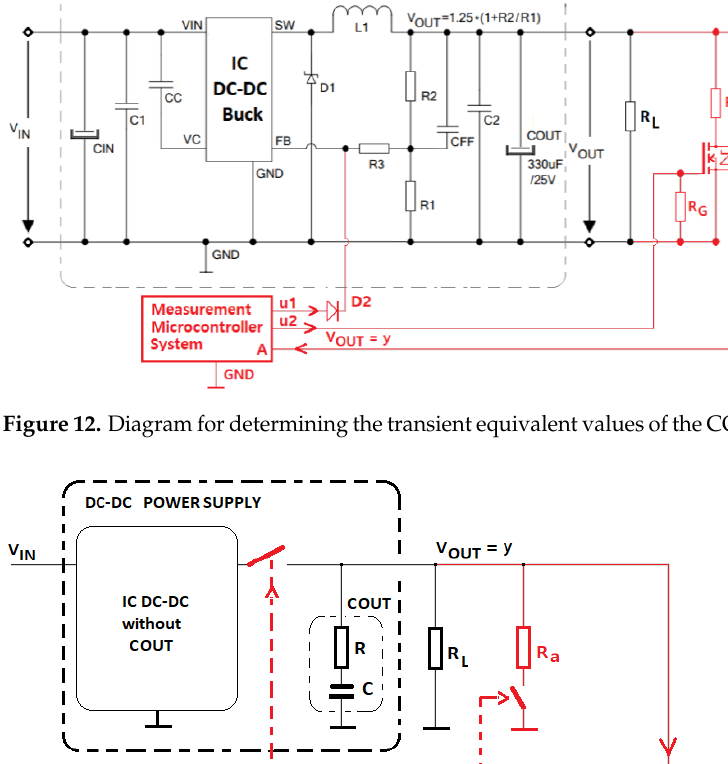
Figure 13. Simplified representation of the diagram in Figure 12.